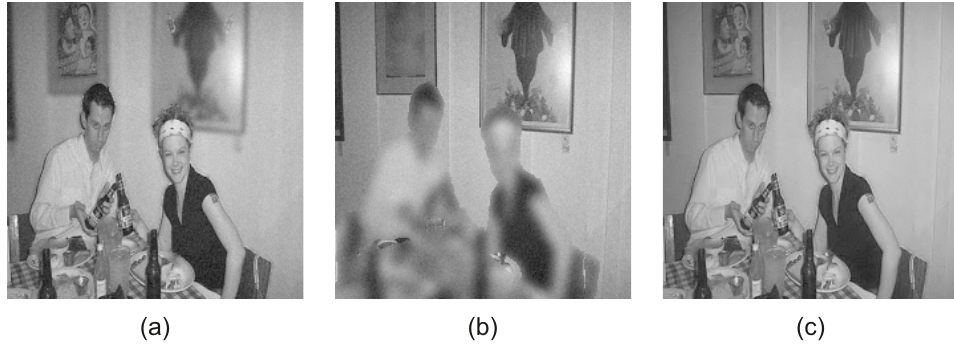
Figure 9. ( a ) Near-focused image with Gaussian noise σ n = 5, ( b ) Far-focused image with Gaussian noise σ n = 5, ( c ) Denoised fused image.